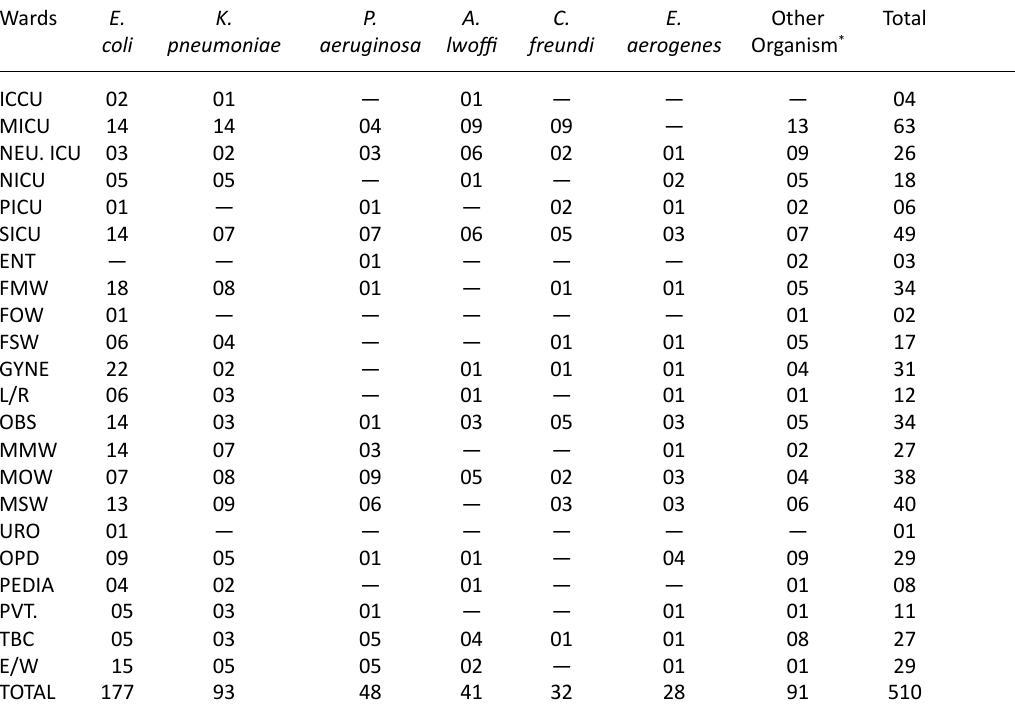
E.coli was species with highest number of gene detected, whereas percentage wise highest rate of gene among MDR isolates were detected in